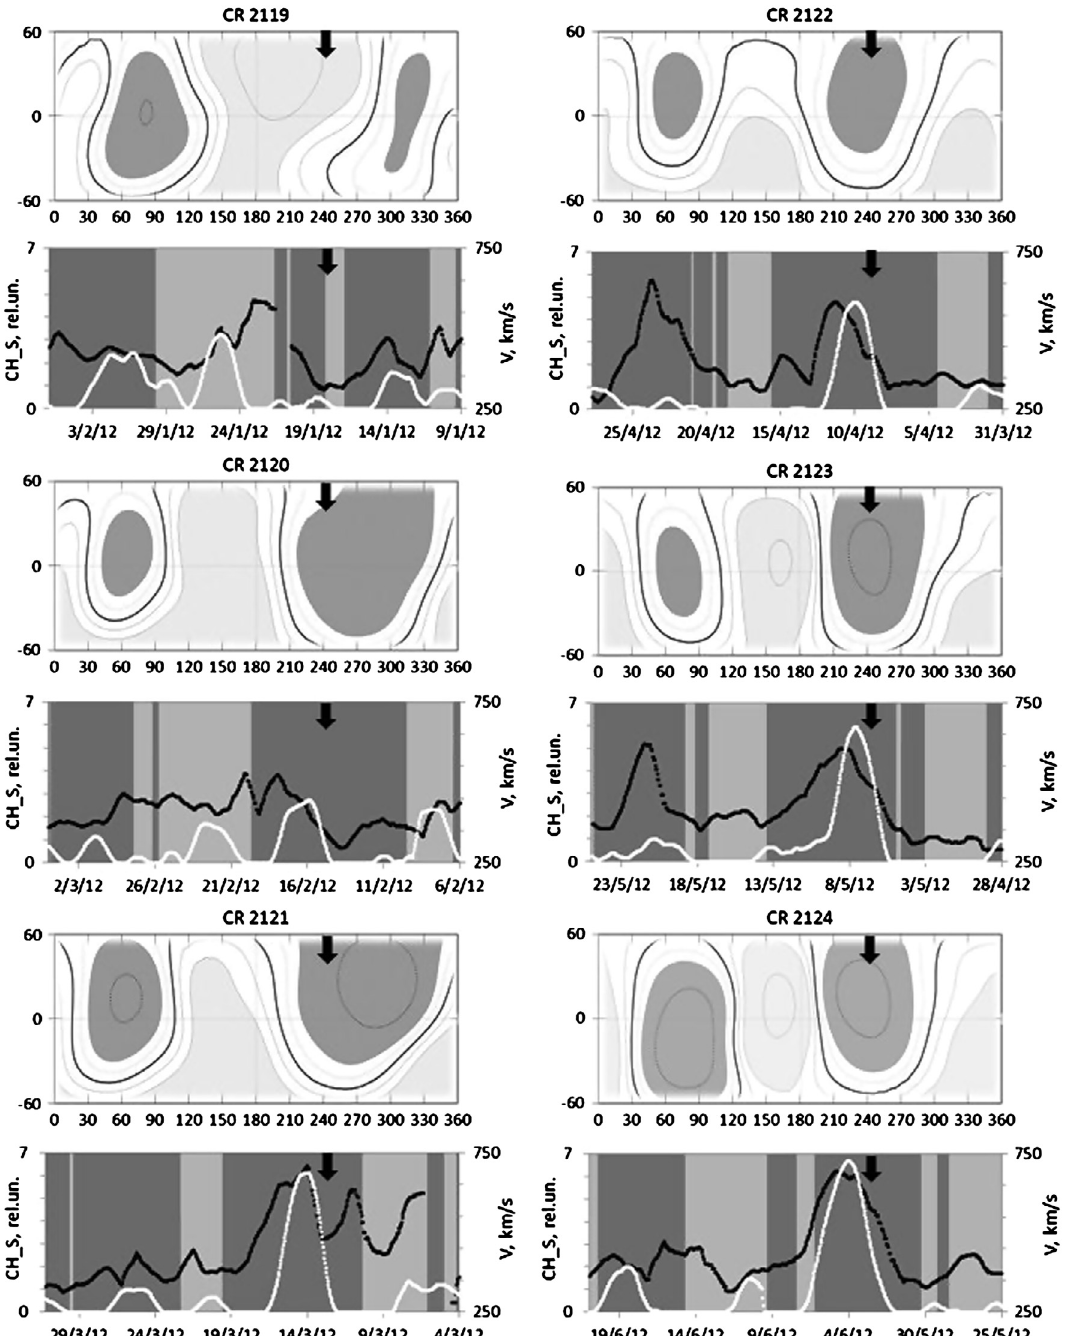
Figure 2a. Evolution of the coronal magnetic field, the areas of CHs and the SW velocity and IMF polarity during CR 2119–2124 recalculated to the source surface. Top panel for each CR: coronal magnetic field maps at the source surface from WSO (positive polarity field are light gray, negative are dark gray). Bottom panel for each CR: IMF polarity (dark gray areas represent positive polarity) as the sign of the 24 h moving average of Bx -component of IMF in the GSM coordinate system, and SW velocity (black curve). White curve is the area of the CHs calculated using the SDO/AIA data. The time axis is directed from right to left for easier comparison with the coronal field map. Black arrows show the analyzed region of the coronal magnetic field associated with the LCH (see Sect.